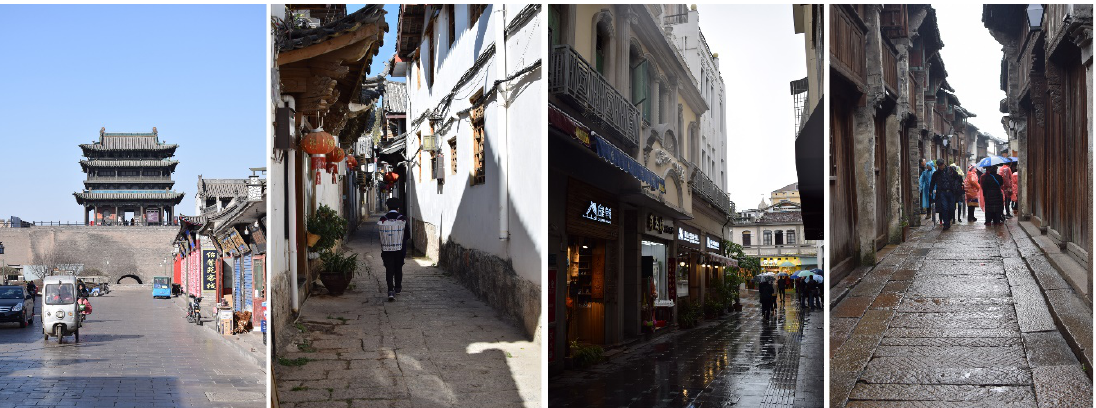
Figure 2. The four HCT case studies, from left to right: Pingyao, Lijiang, Kulangsu, and Wuzhen [photos were taken by the lead author].